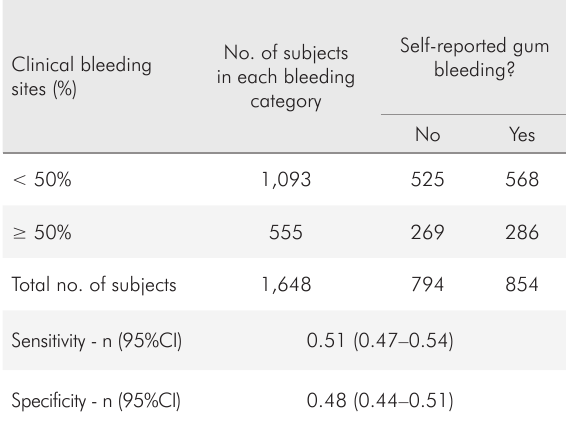
Table 7. Self-reported gum bleeding and percentage of bleeding sites (threshold ≥